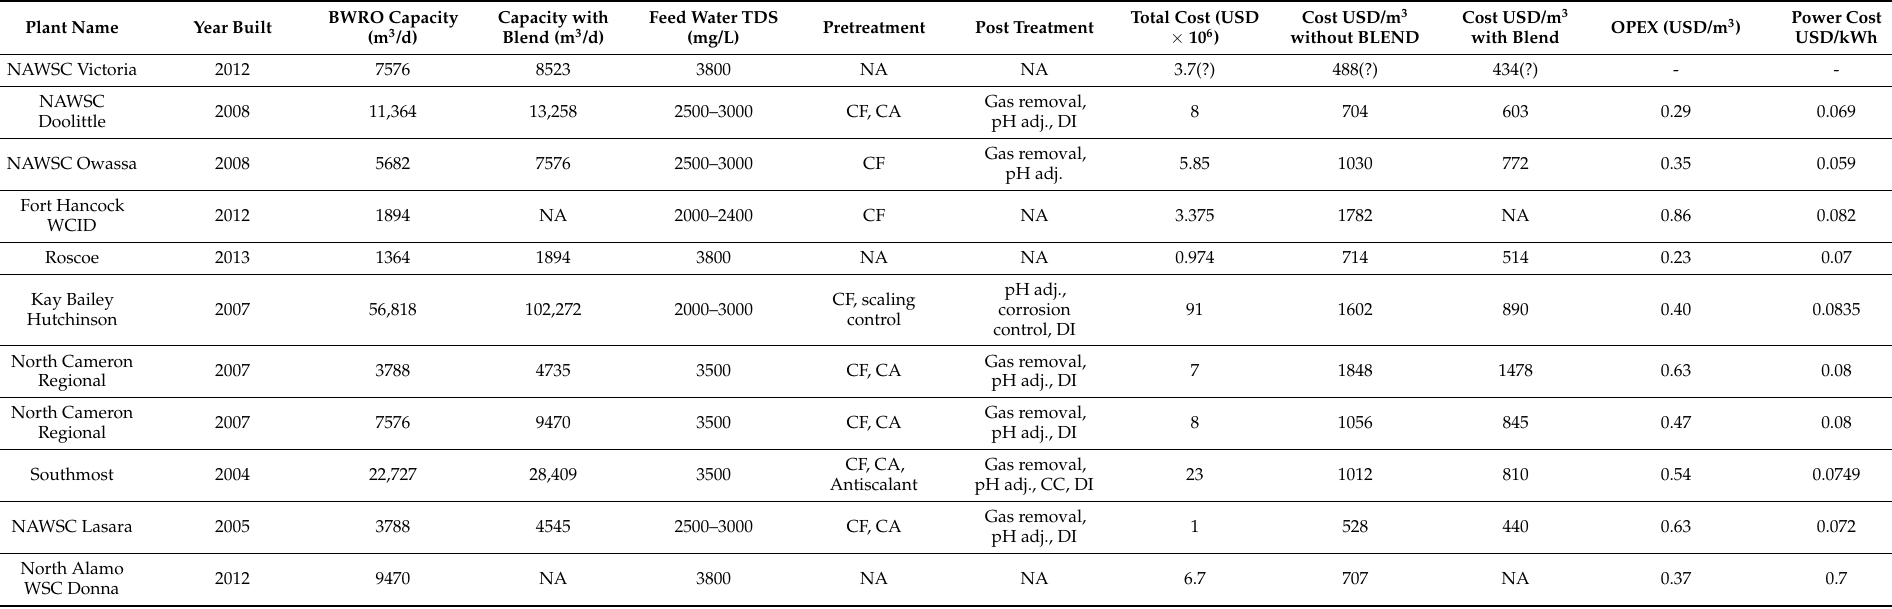
Table 3. BWRO plants in Texas USA (recalculated from Arroyo and Shirazi [43], original costs in year constructed). Note that the compiled consumer cost index increase from 2002 to 2020 is about 38% or close to 2%/year in the